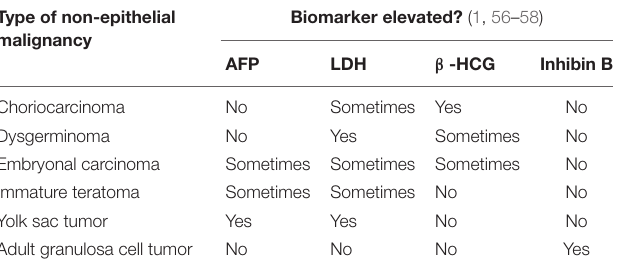
TABLE 2 | Biomarkers for non-epithelial ovarian